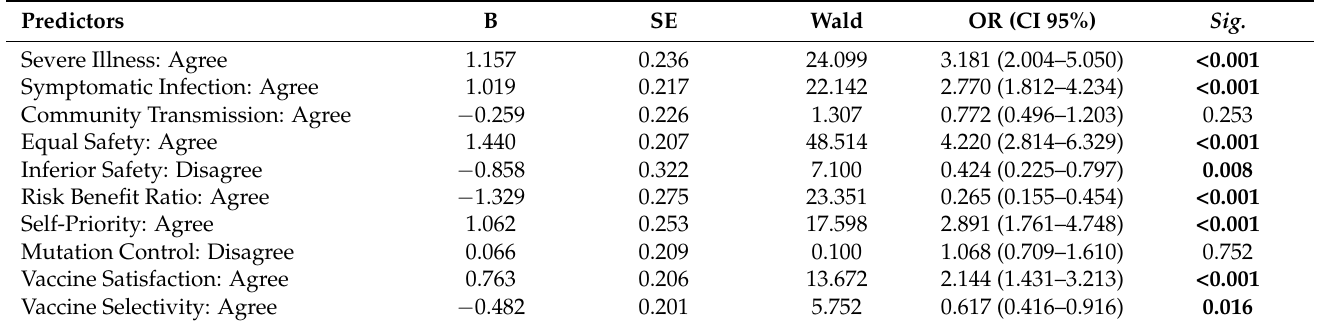
Table 7. Multivariate logistic regression analysis of proposed psychological drivers for acceptance of COVID-19 vaccine BD among the healthcare professionals of